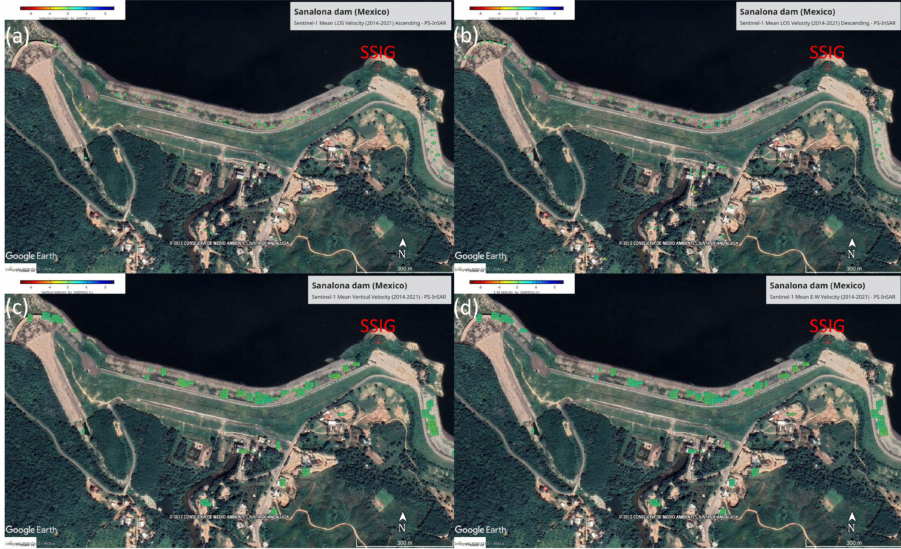
Figure 6. Mean velocity maps for the MT-InSAR analysis of the Sanalona dam. ( a ) Ascending dataset in the LOS direction. ( b ) Descending dataset in the LOS direction. ( c ) Decomposed vertical direction. ( d ) Decomposed E–W